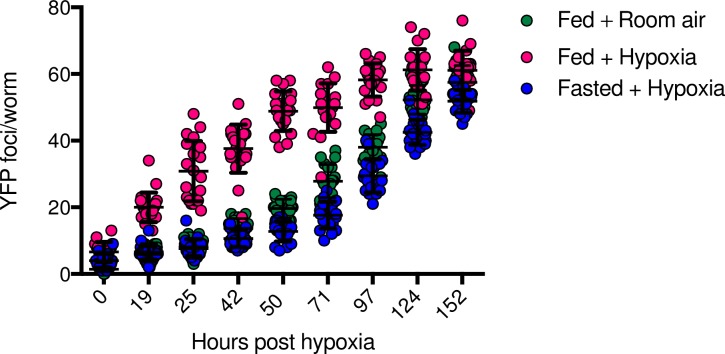
Fasting protects against long-term effects of hypoxia on proteostasis.Cohorts of L4 Q35::YFP animals were exposed to hypoxia (H = 10 h) on food (magenta) or fasted (blue, F = 6h). Controls remained in room air on food (green). The number of YFP foci was scored after return to room air as indicated. Data from one representative experiment is shown. The experiment was repeated at least 3 times. Each cohort included at least 20 animals per time point. Summary statistics from independent replicates are in S10 Table.